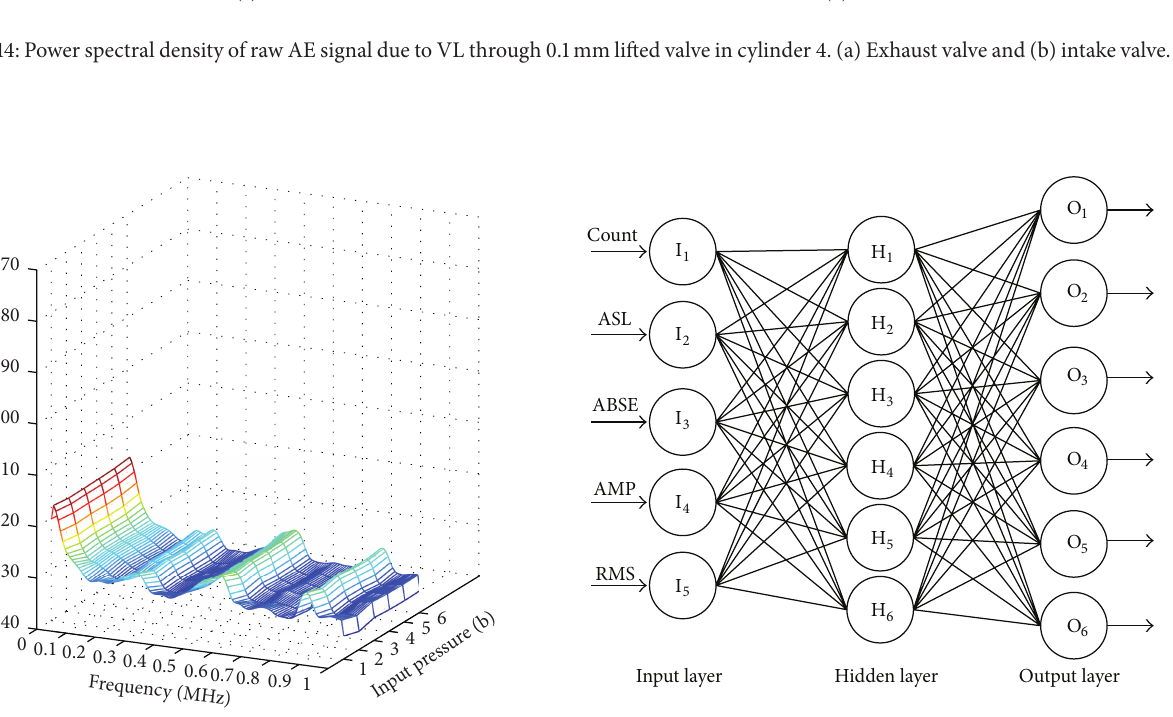
Figure 15: Power spectral density of raw AE signal for healthy valves with no leakage in cylinder 4.